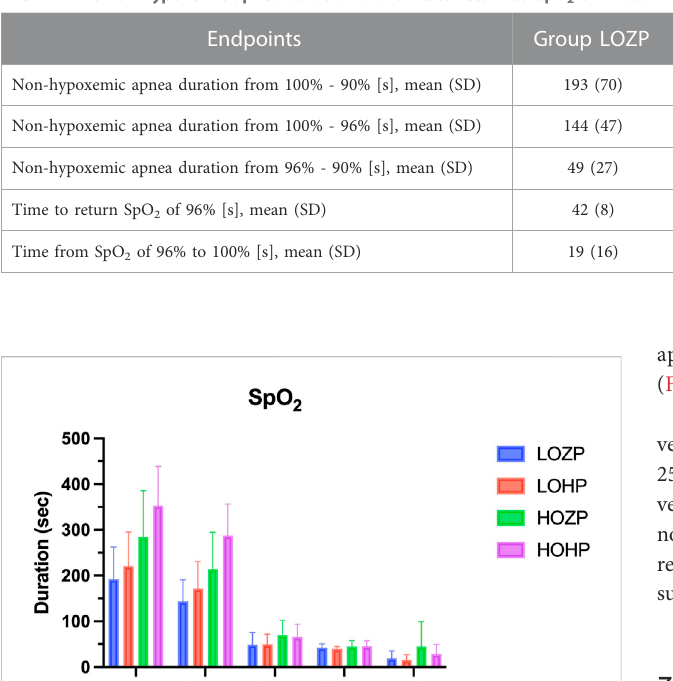
TABLE 2 The non-hypoxemic apnea duration and time to return to SpO 2 of 100%.